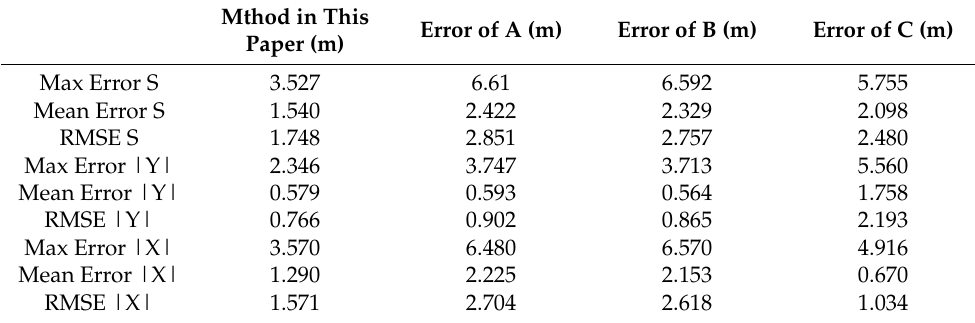
Table 5. Errors of comparative